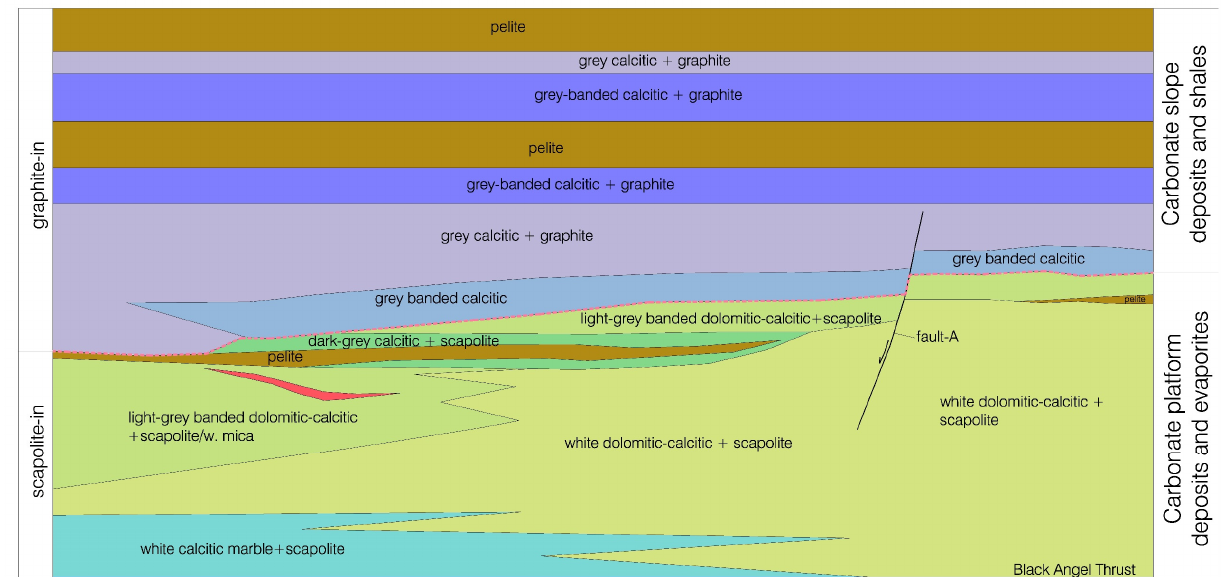
Figure 9. Stratigraphic chart of the folded Black Angel pelites after restoration of ca. 1800 m wide and 600 m thick rock package, showing the relationships of the stratigraphic units above and below the pelites (not to scale). Red color corresponds to the ore deposit; legend as in Figure 7. The reconstructed stratigraphic chart (Figure 9) refers to the area around the Black Angel pelite and extends south-east of fault-A (Figure 7b). The data show scapolite-rich marbles in the lower part and graphite-rich marbles in the upper part (Figure 9). The iron index (Figure 6b) suggests the presence of oxidized iron in the dolomitic marbles and reduced conditions in the graphitic marbles. The scapolite-rich marbles are mostly dolomitic, apart from the white calcitic marbles at the bottom, and probably represent the car- always calcitic and are intercalated with thick pelites, probably represent the carbonate slope facies deposits and shales. The Black Angel pelite, which is intercalated with c. 7 m dark-grey scapolite-rich calcitic marbles, is interpreted as maximum flooding surface that closely coincides with the graphite/scapolite boundary (Figure 9) and marks the drowning of the platform. Finally, the ore body is hosted within light-grey scapolite-rich dolomitic-